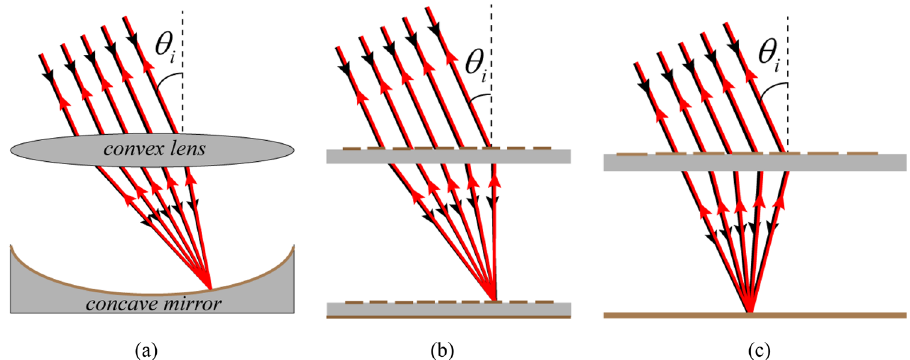
Figure 1. ( a ) Illustration of a conventional cat’s eye retroreflector composed of a convex lens and a concave mirror placed behind the lens. ( b ) Illustration of a planar retroreflector of the first method. ( c ) Illustration of a planar retroreflector of the second method.